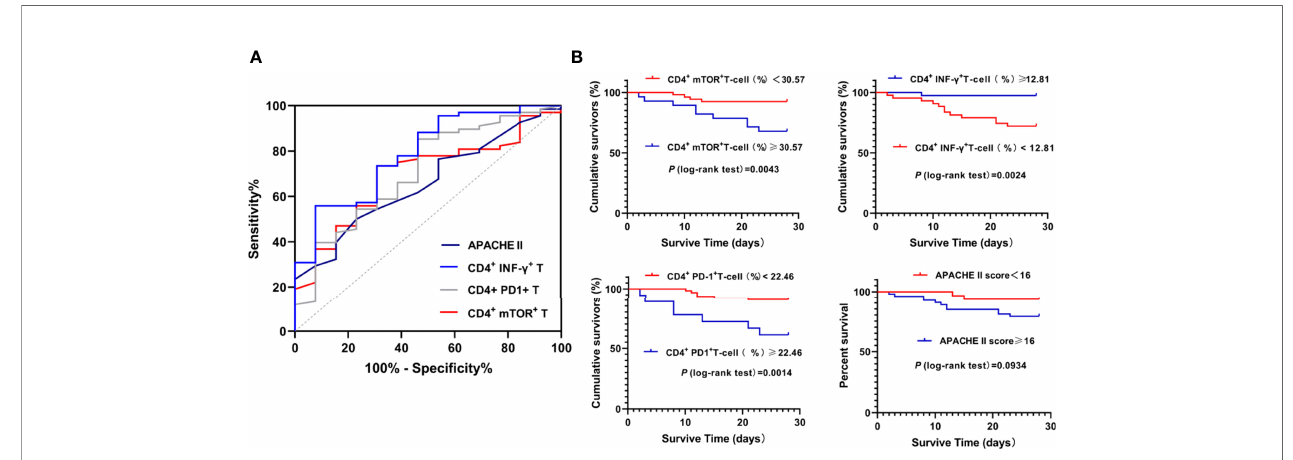
FIGURE 2 | ROC analysis and Kaplan-Meier analysis of parameters predicting D28 Mortality. ROC analysis of parameters predicting D28 Mortality (A) and Kaplan- Meier analysis of survival probabilities in Septic study population (B)